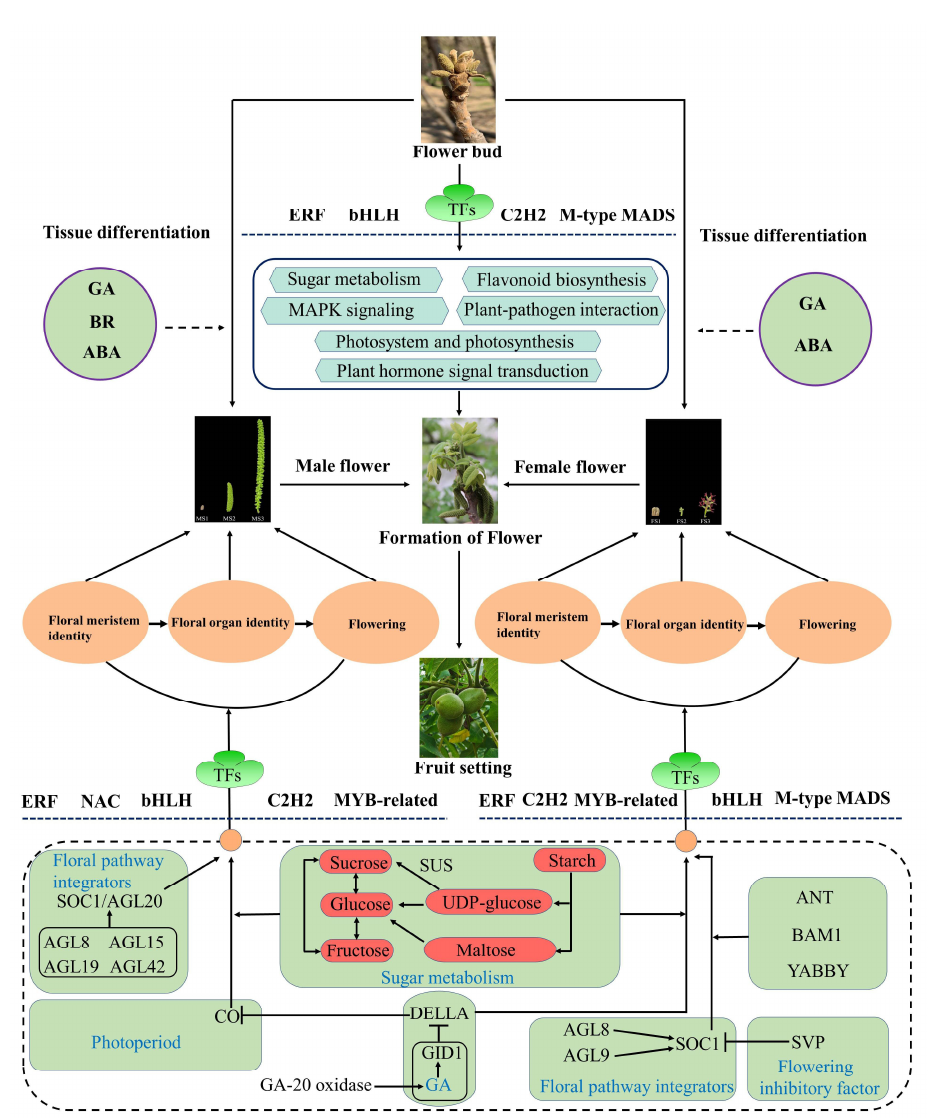
Figure 12. Schematic diagram of the regulatory mechanism for inflorescence development in J. mandshurica . J. mandshurica